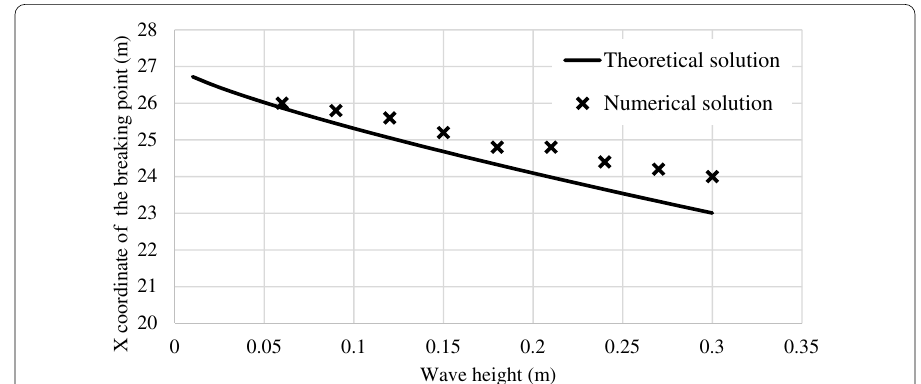
Fig. 6 Compare of the x coordinates of the breaking point between numerical solution in this study and theoretical solution by Grilli et al.